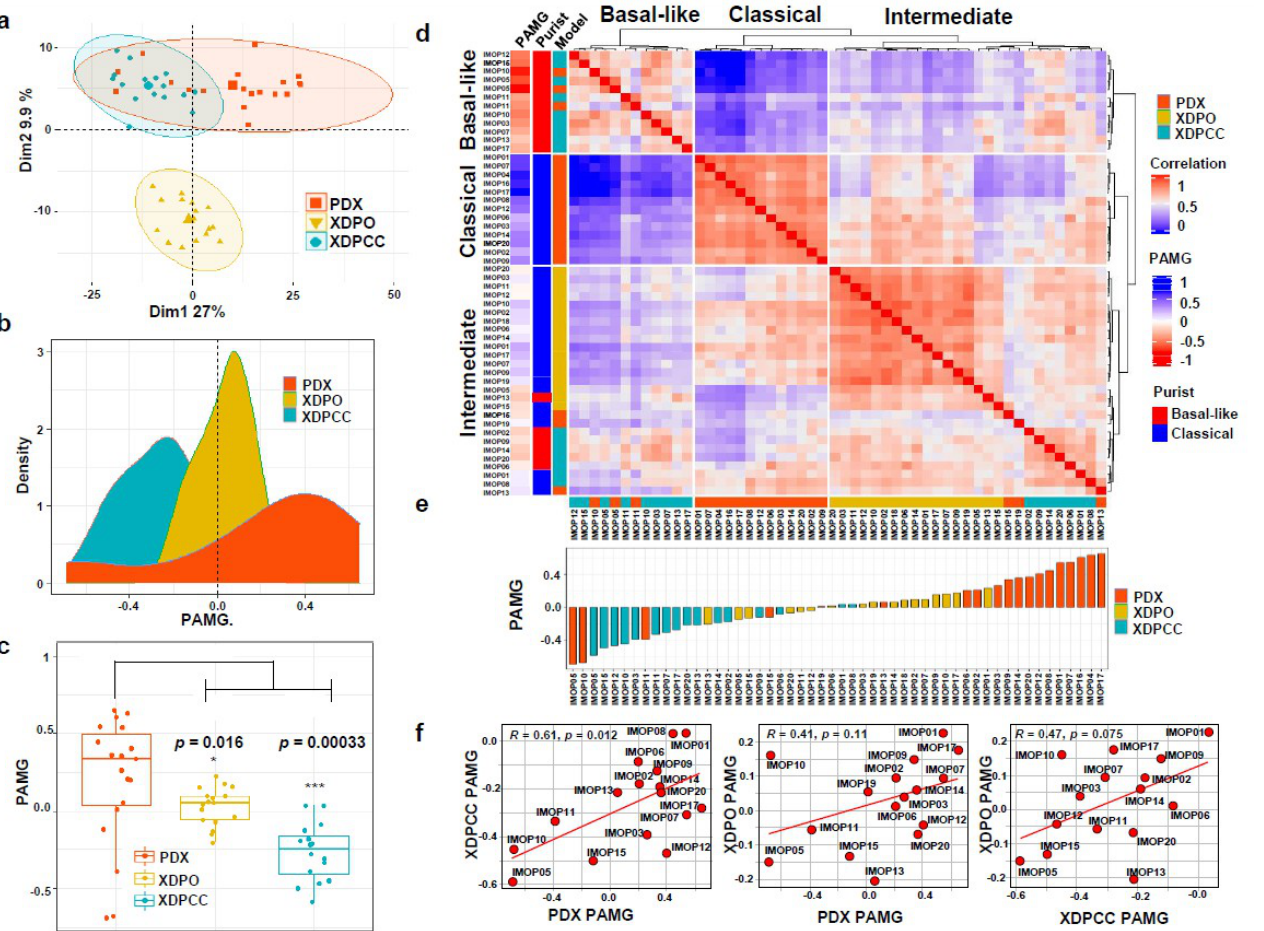
Figure 2. Phenotypic analysis of PDX, XDPO and XDPCC. ( a ) A PCA plot was generated with the top 634 basal-like and classical markers across all three models. ( b ) Density plot showing the distribution of the PAMG across all three models. ( c ) Boxplot and Wilcoxon t-test illustrating the PAMG profile of each model examined. ( d ) ComplexHeatmap with correlation matrix using the 634 top basal-like and classical markers. Annotations to the left and right of the heatmap indicate, the Molecular Grade (PAMG), the PurIST classification and the model type. ( e ) Ranking of the Molecular Gradient (PAMG) across all three models from highest to lowest. Higher values indicate more classical and lower values indicate more basal-like. ( f ) Correlation co-efficient plots generated comparing all models using the PAMG, regression values and p- values.